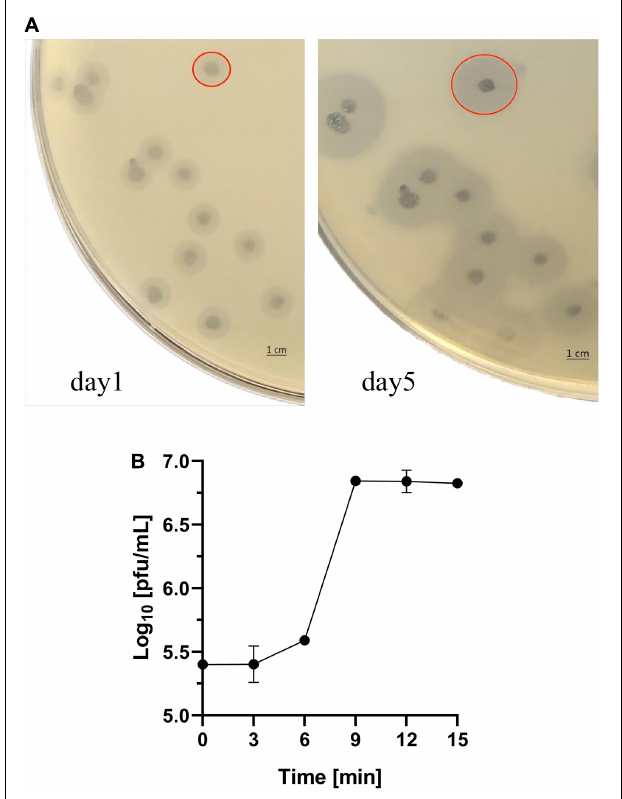
FIGURE 1 | Characterization of Phage SH-KP156570. (A) Interaction between the phage and K. pneumoniae strain 6570. Plagues were formed on the plate. Faint halos could be observed around the plaque on day 1 and the size of the faint halos increased by day 5. The red circle in the picture represented the size of the plaque and halo. (B) One-step growth curve of SH-KP156570. The burst size was calculated as the ratio of the final count of phage particles to the bacterial cells. Phage concentration in PFU/mL as a function of time post-infection was plotted. Error bars represent mean ±